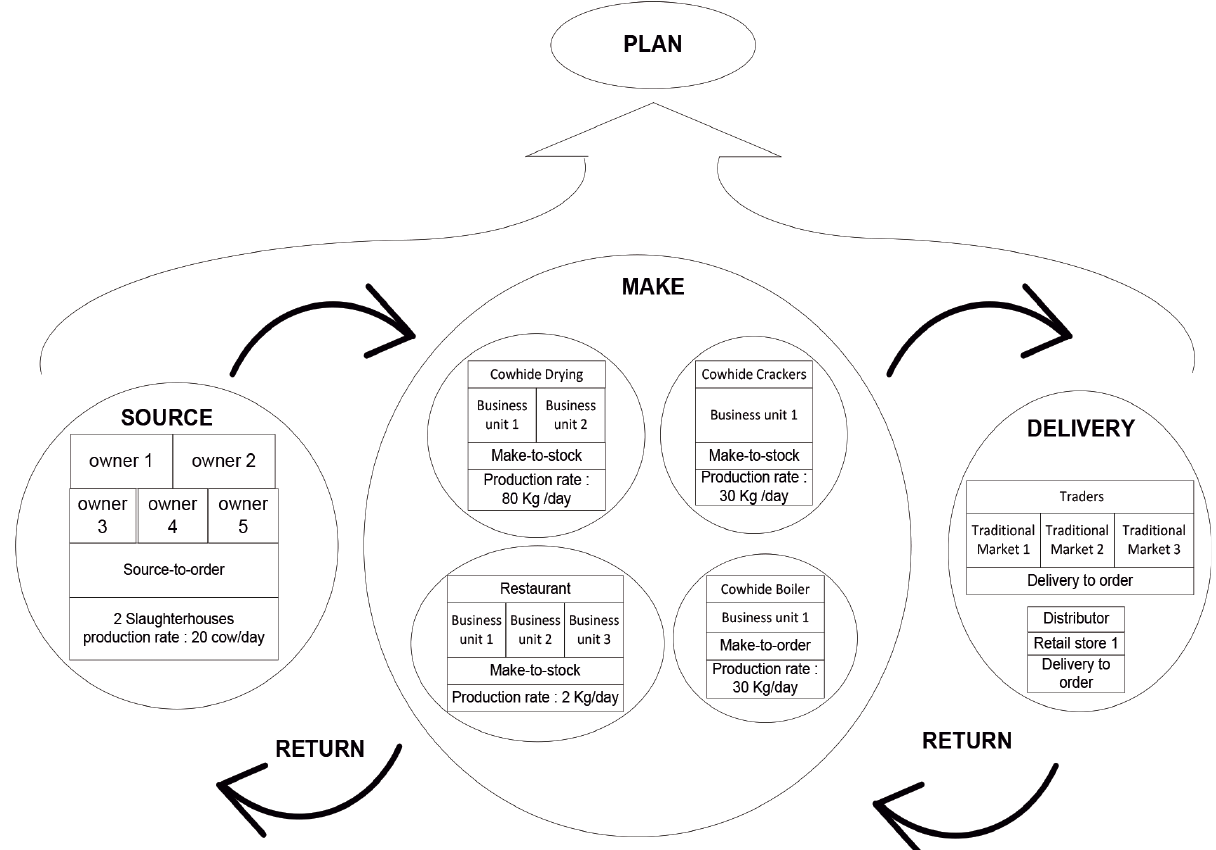
Figure 4. Supply chain of distribution channel using the SCOR